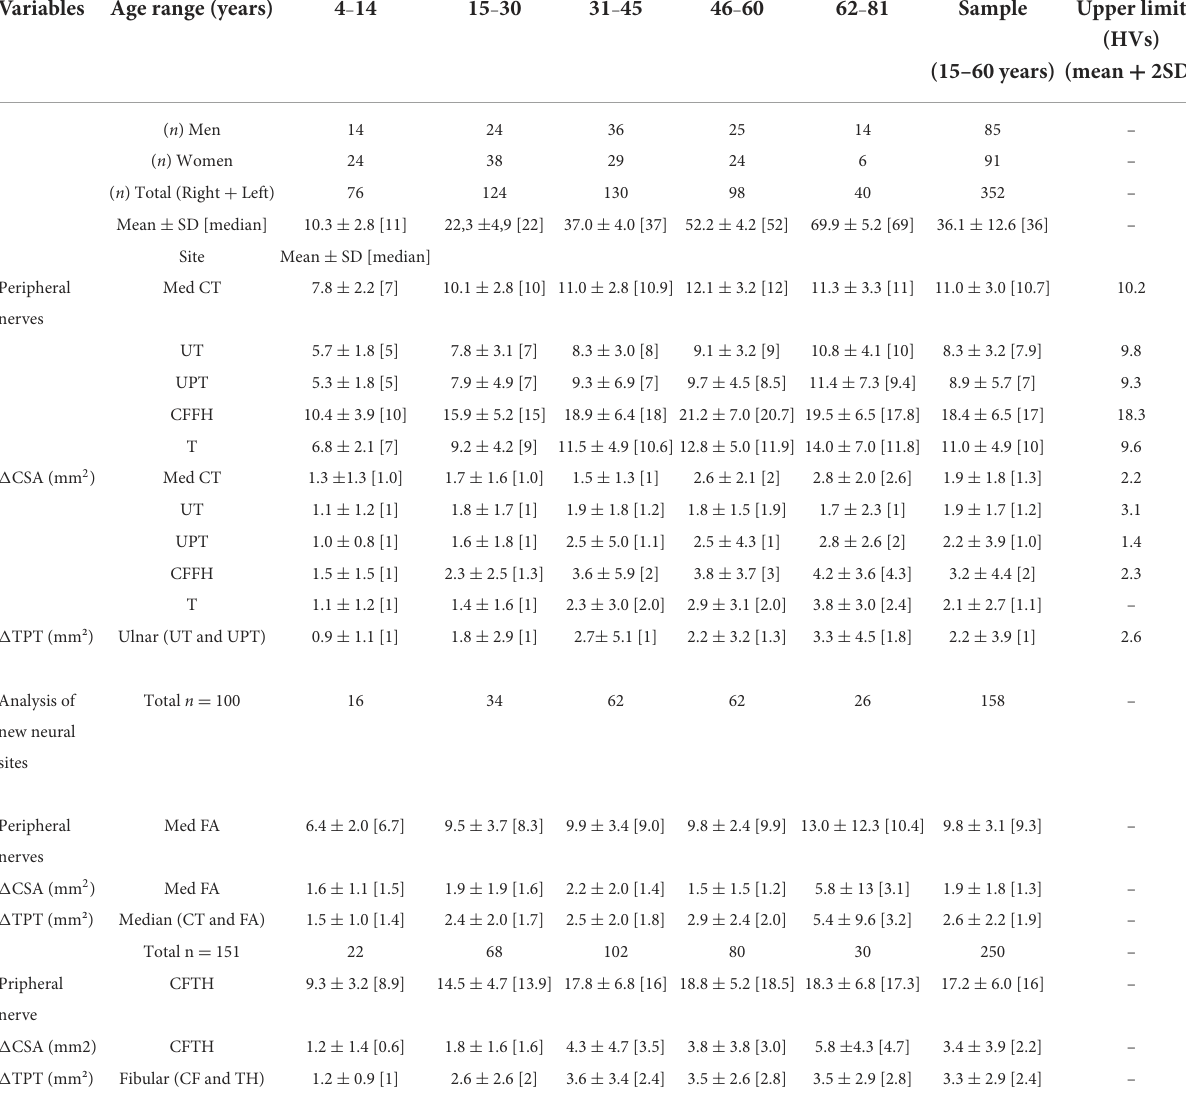
TABLE 2 Distribution of ultrasound measurements (CSA, 1 CSA, and 1 TPT) according to age range, total sample, and upper limit.